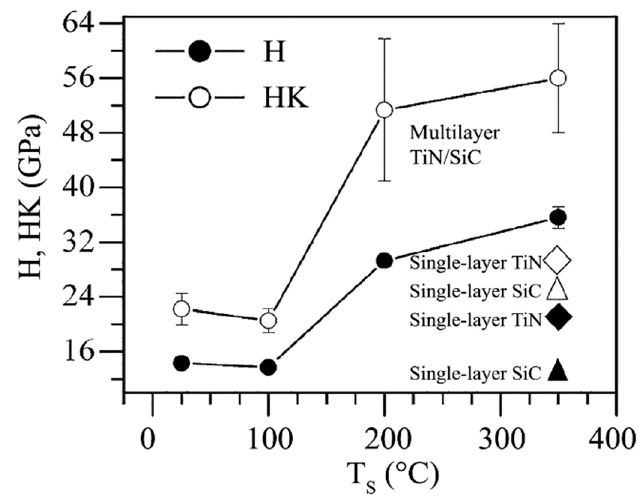
Figure 19. GIXRD patterns for multilayer TiN/SiC films deposited at different substrate temperature from 25 to 350 ◦ C and single-layer SiC and TiN films obtained at T s = 350 ◦ C. Red and black lines are consistent with SiC and TiN films, respectively; * indicates a hexagonal phase. Reprinted with permission from [152] 2018 Elsevier.